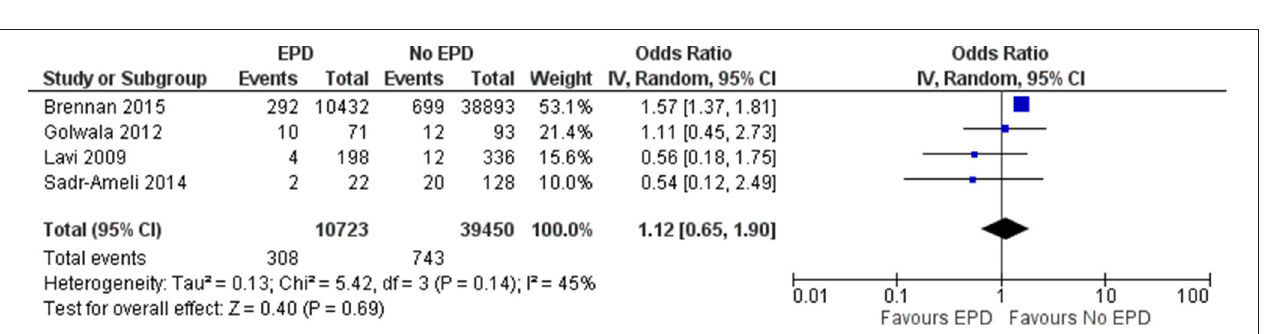
FIGURE 3 | Forest plot showing the difference in target vessel revascularization (TVR) between patients with and without EPD following PCI on SVG ( n = 7).